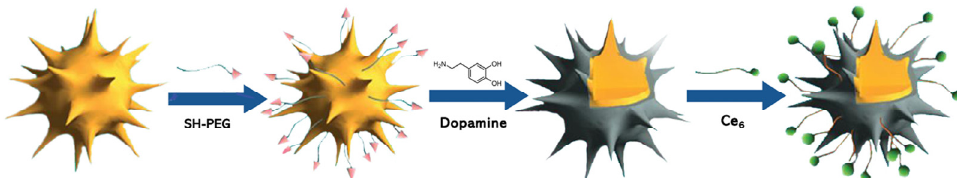
Figure 14. Representation of Ce 6 -conjugated and polydopamine-coated gold nanostars (Ce 6 -PDA@AuNSs) (reproduced from Reference [86] with permission from the Royal Society of Chemistry).